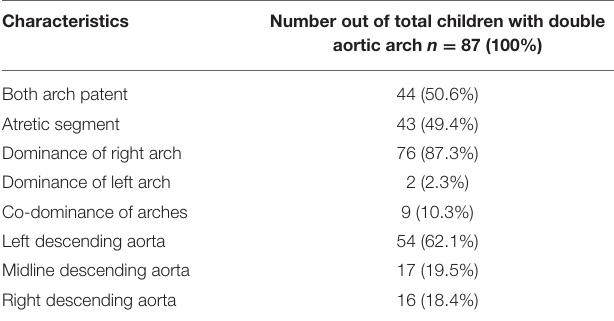
TABLE 2 | Baseline anatomical factors within double aortic arch morphology.